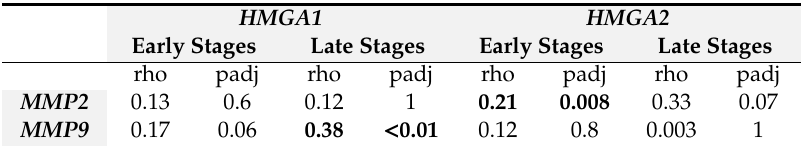
Table 3. Correlation analyses between HMGA genes and metalloproteinases ( MMP ) expression assessed in samples from 381 endometrioid endometrial adenocarcinoma (EEC) patients from The Cancer Genome Atlas (TCGA) database evaluated in the